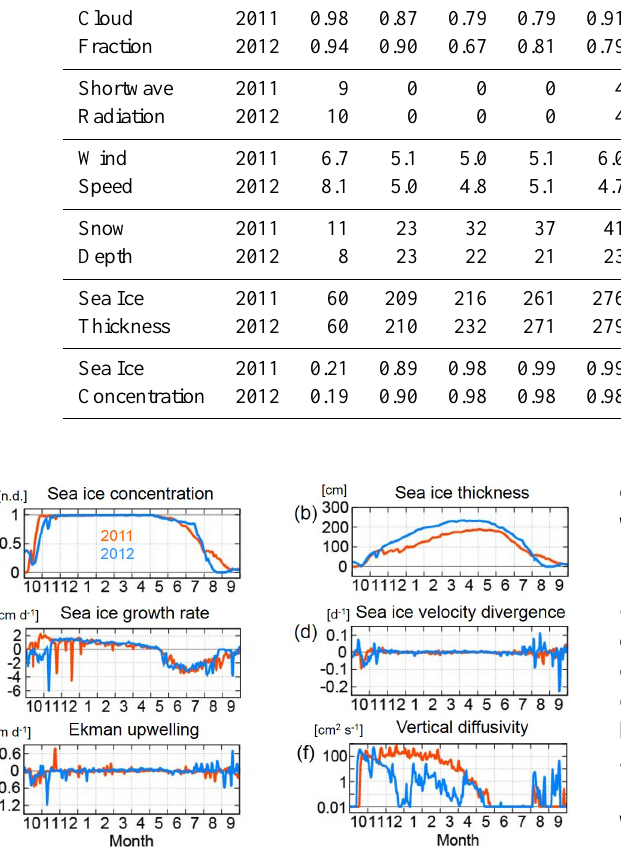
Figure 4. Seasonal transition of daily mean modeled variables in the NAP region. (a) Sea ice concentration (n.d.), (b) sea ice thickness (cm), (c) thermal growth rate of sea ice (cmd − 1 ) , (d) divergence of sea ice velocity (d − 1 ) , (e) Ekman upwelling velocity diagnosed using ocean surface stress fields (md − 1 ) , and (f) vertical diffusiv- ity at the depth of 20m (cm 2 s − 1 ) in the 2011 (red line) and 2012 (blue line) cases. Note that negative values in (c) , (d) , and (e) cor- respond to sea ice melting, convergence of sea ice velocity, and Ek- man downwelling, respectively. Vertical diffusivity in (f) is shown in a logarithm